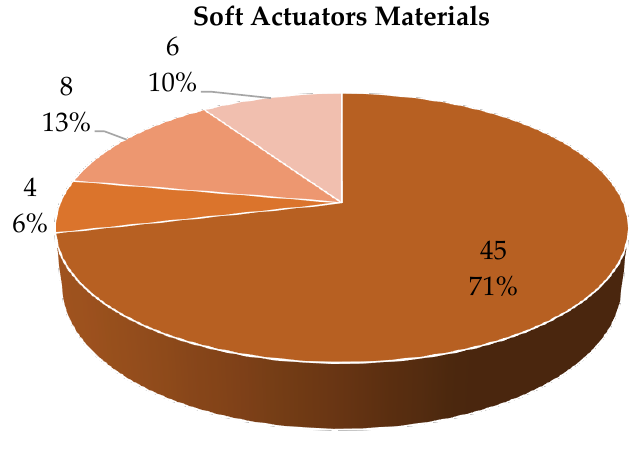
Figure 30. Main material of which the soft actuator is made. Silicon rubber mainly used have 30 Shore A hardness. TPU stands for Thermoplastic Polyurethan.